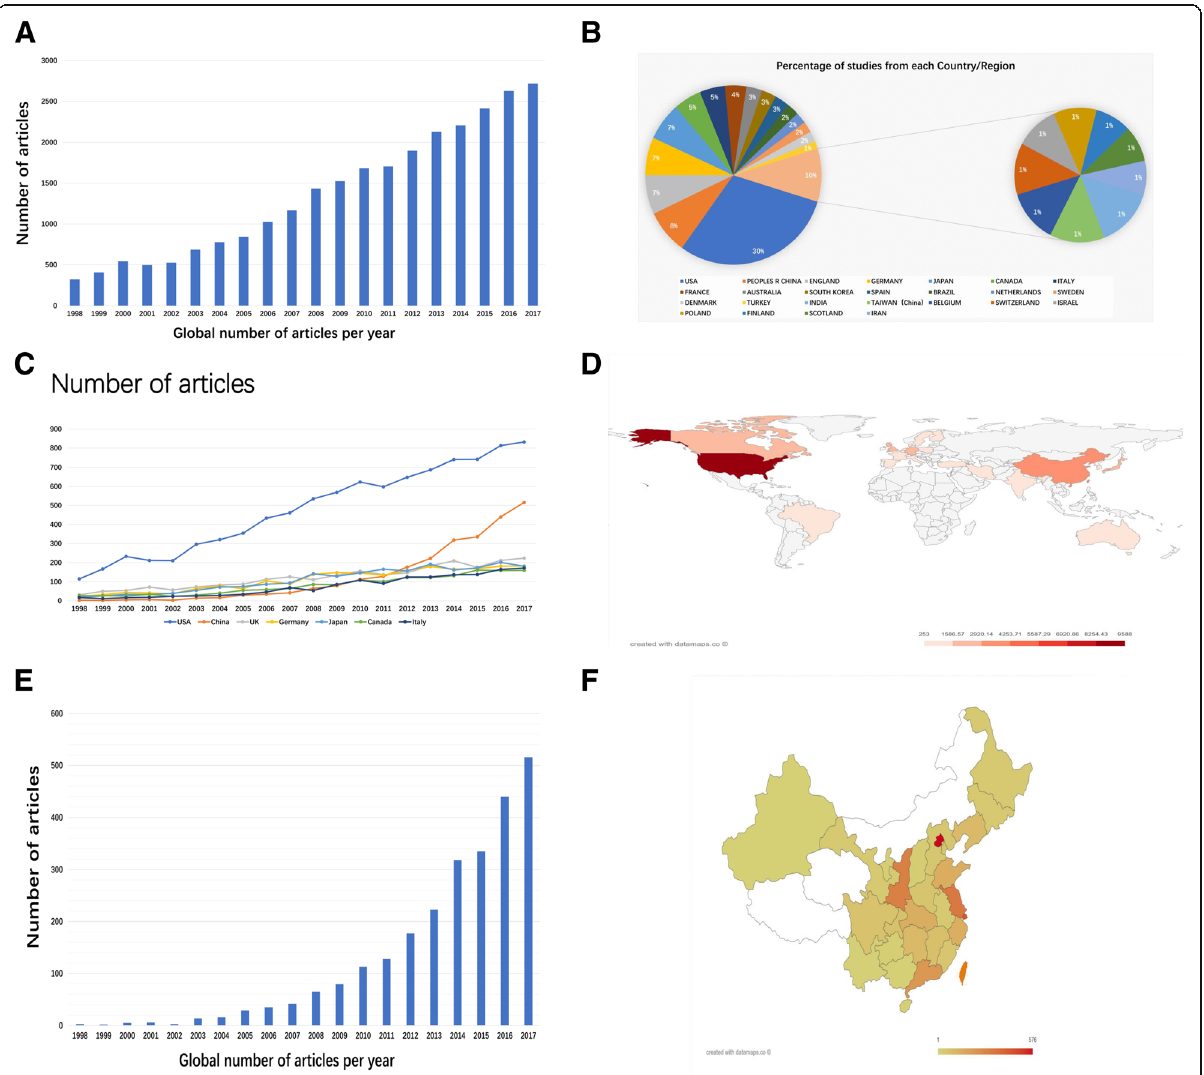
Fig. 1 Neuropathic pain related articles in world and in China ( a ) The global number of neuropathic pain publications. The blue bars indicate the quantity of neuropathic pain articles. ( b ) Percentage of studies from each Country/Region. ( c ) The time curve of neuropathic pain articles from top 7 countries. ( d ) The heat map showing the distribution of neuropathic pain publications in world. ( e ) The annual number of neuropathic pain articles in China. ( f ) The heat map showing the distribution of neuropathic pain publications in